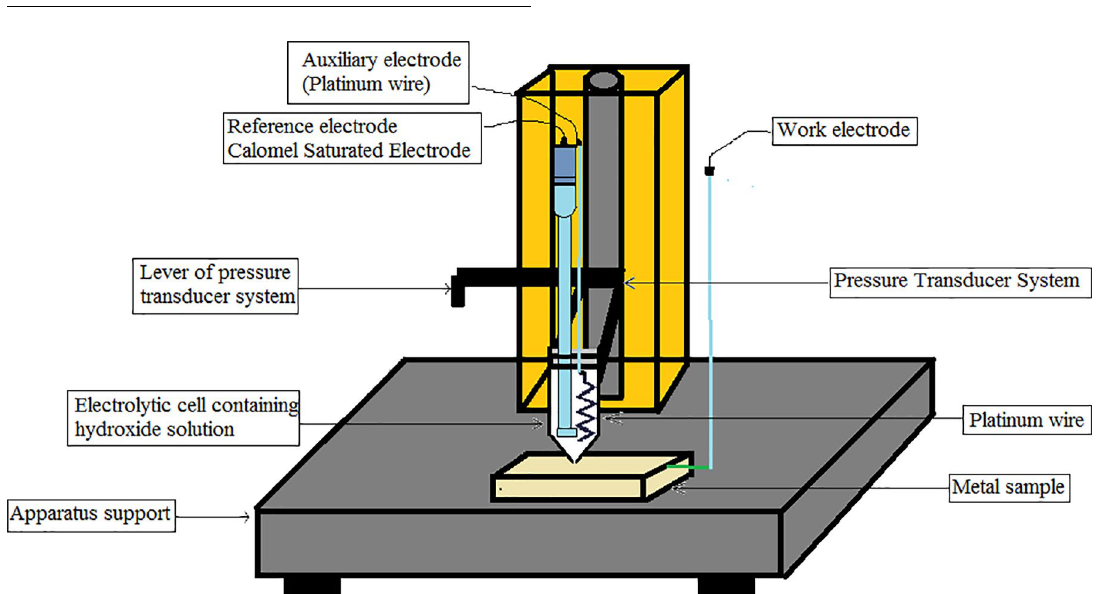
Figure 1. Schematic representation of the experimental apparatus used to perform Linear Sweep